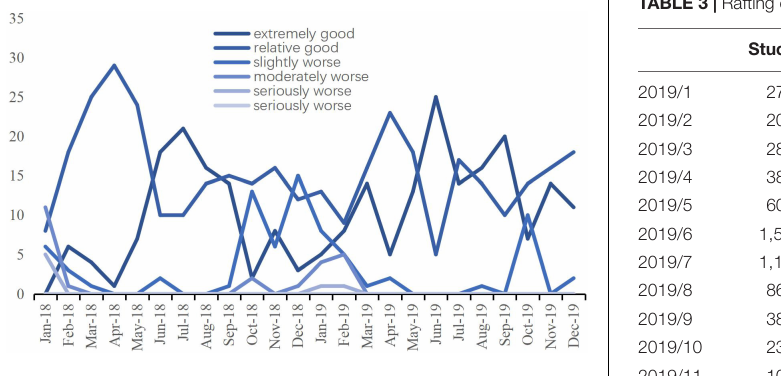
FIGURE 2 | Historical air quality distribution in Nanning province.